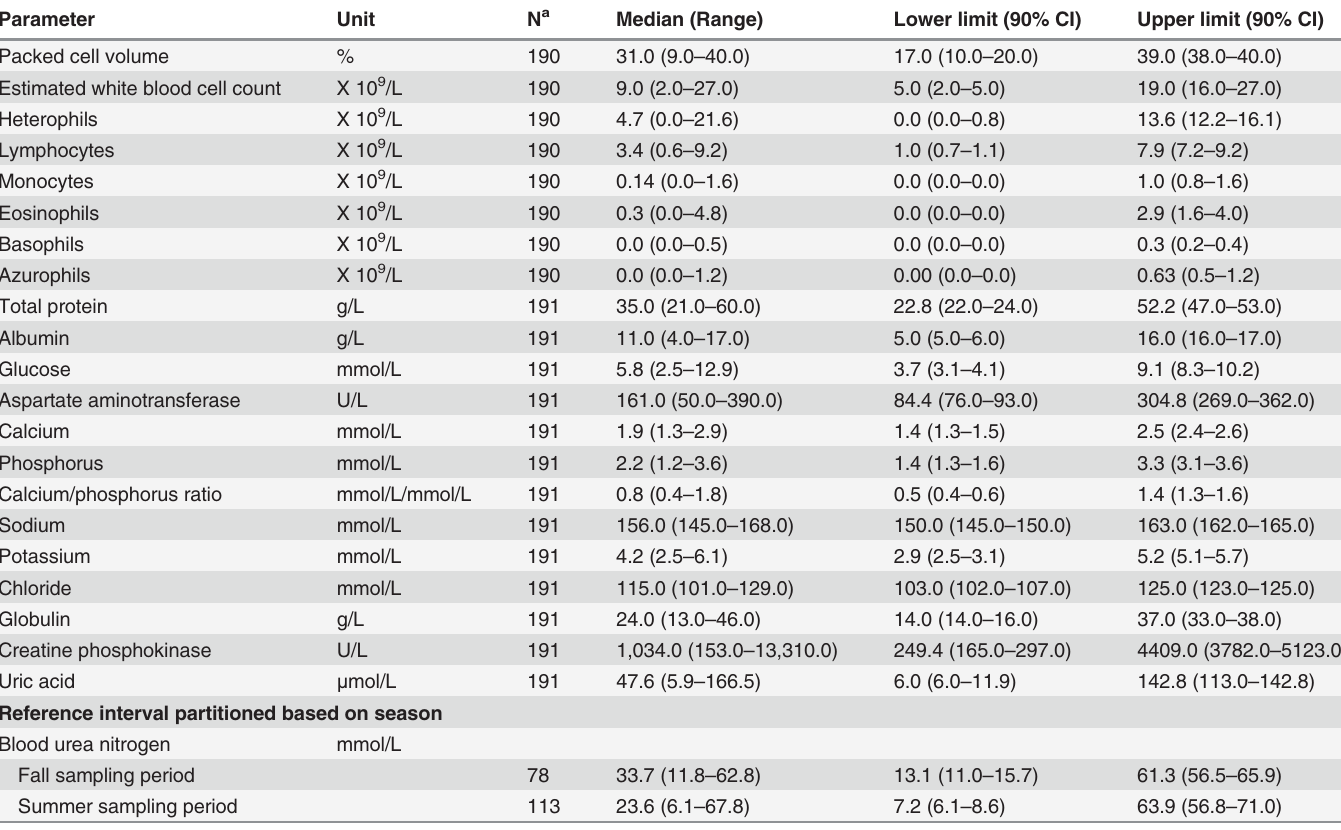
Table 1. Hematology and plasma biochemistry reference intervals and 90% con fi dence intervals for a population of 191 apparently healthy juvenile loggerhead sea turtles ( Caretta caretta ) sampled in Core Sound, North Carolina, USA from 2004 – 2007.